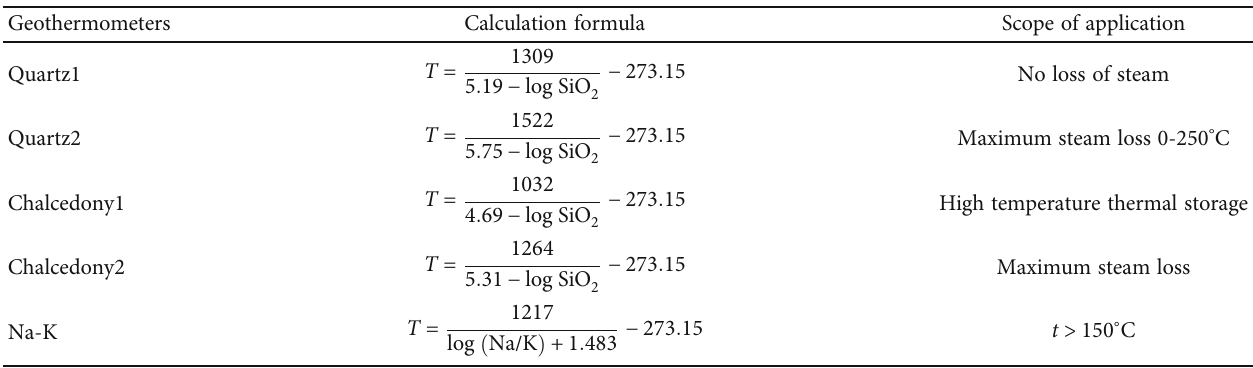
Table 6: Geothermometer function of geothermal water in the study